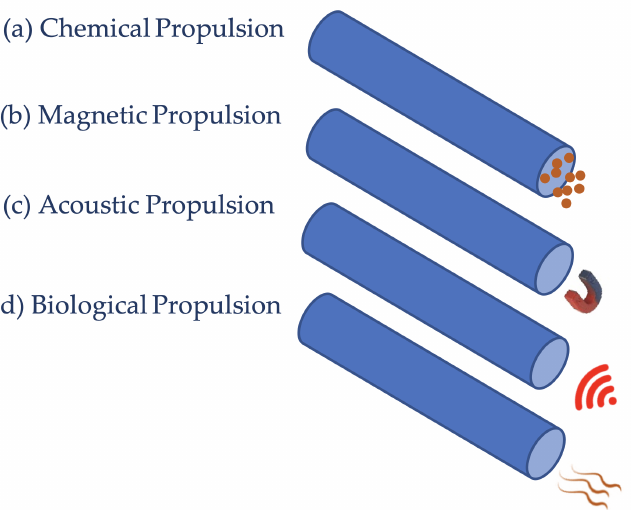
Figure 2. Four different concepts for propulsion: ( a ) Chemical Propulsion, ( b ) Magnetic Propulsion, ( c ) Acoustic Propulsion, ( d ) Biological Propulsion.